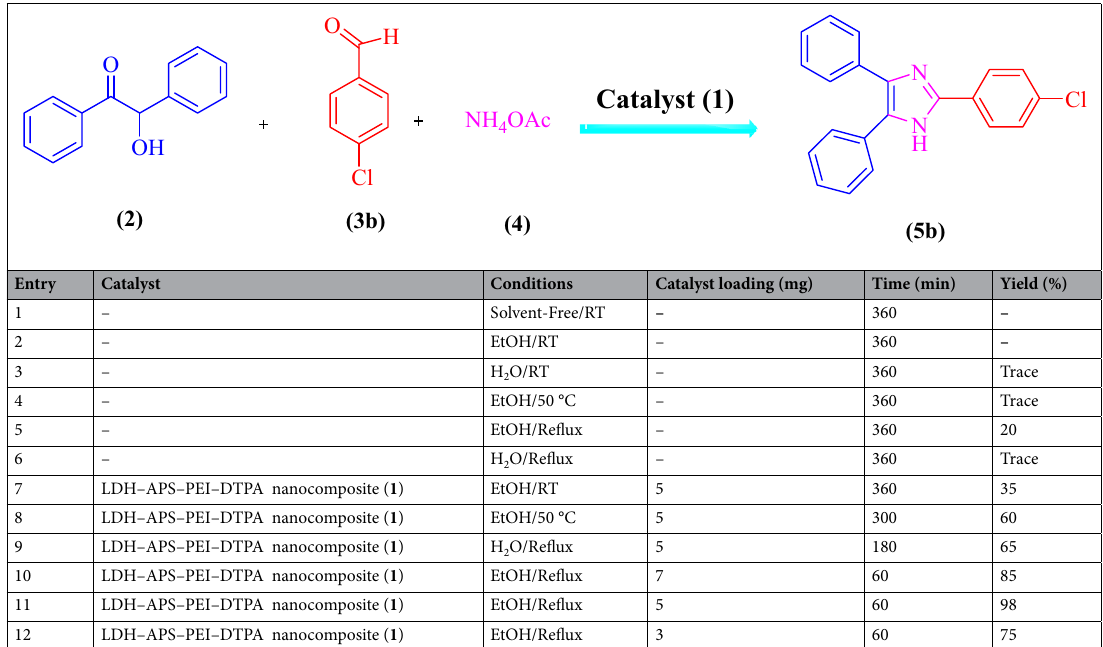
Table 1 . Synthesis of imidazole derivatives 5a – k by the three-component condensation of benzoin ( 2 ), aldehyde derivatives 3a – k , and ammonium acetate ( 4 ) in the presence of